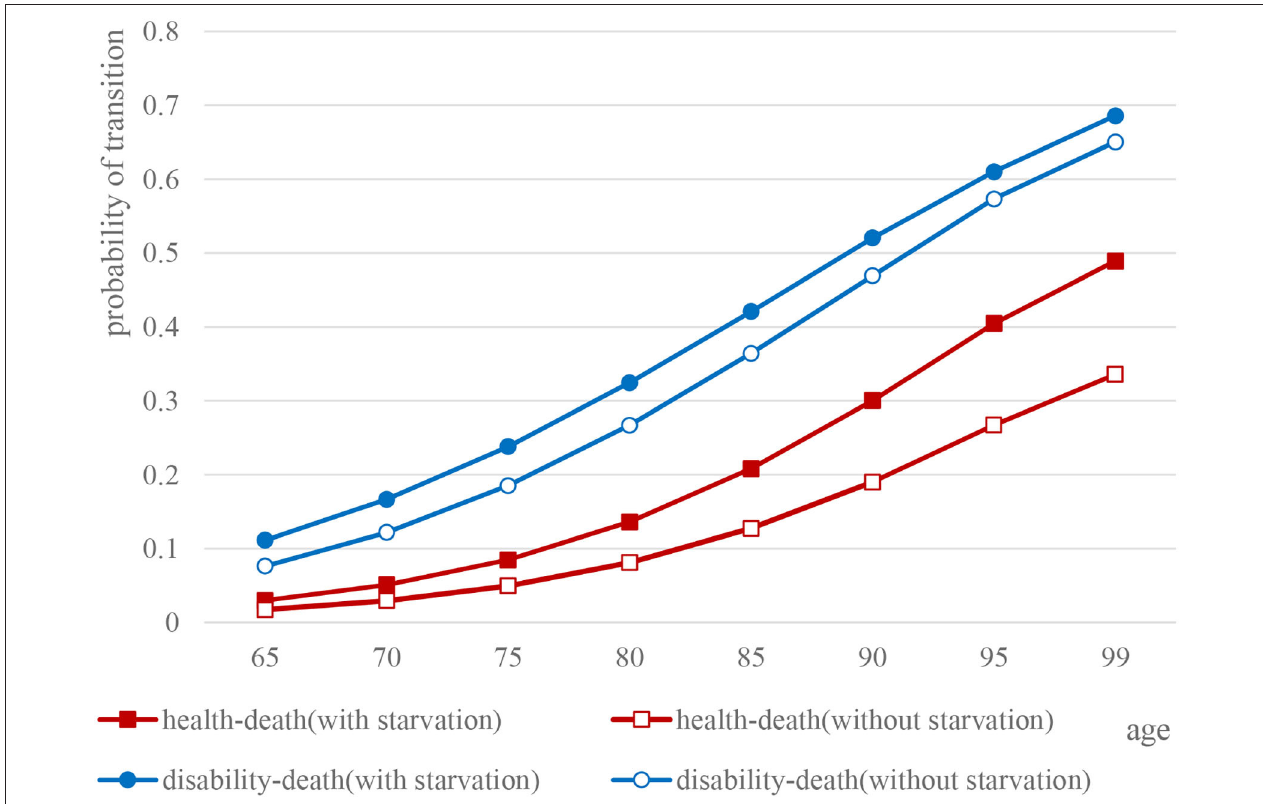
FIGURE 5 | Comparison of health and death transition probability curves of elderly females.